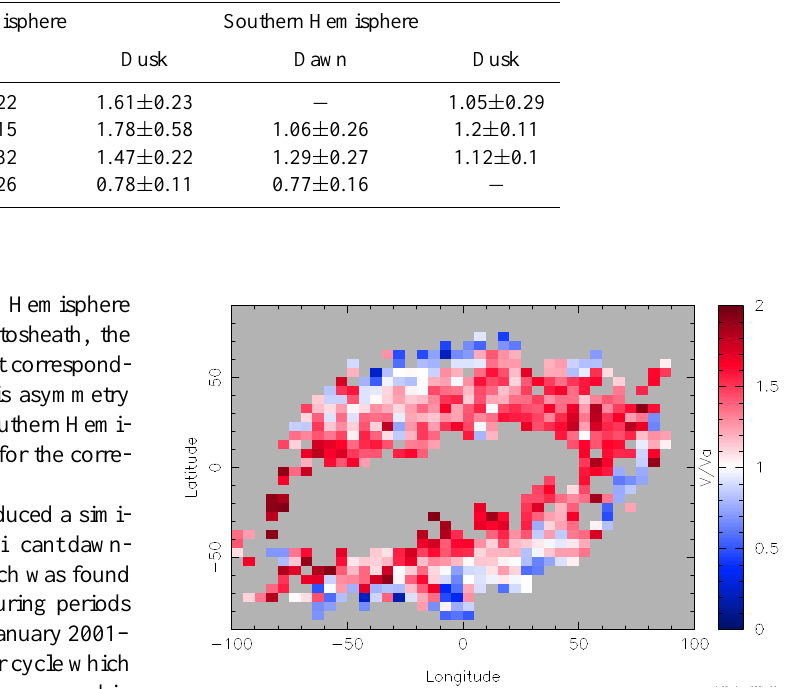
Table 1. Alfv´en mach number, M A for the 25% of the magnetosheath adjacent to the magnetopause